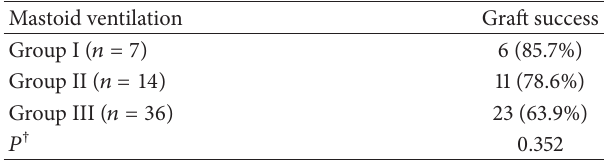
Table 2: Graft success rates of the mastoid ventilation groups at the 12th